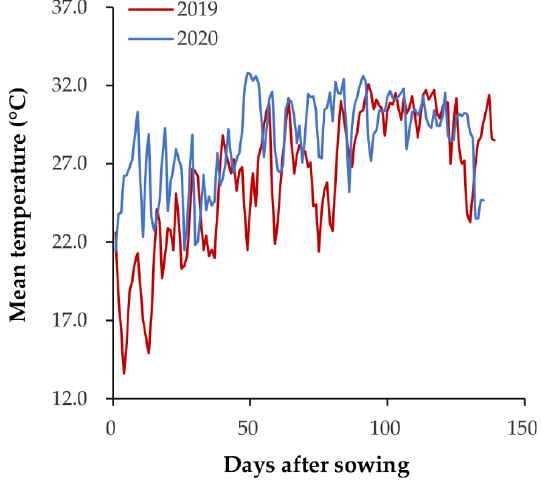
Figure 1. Daily mean temperature during the rice-growing season in 2019 and 2021 .